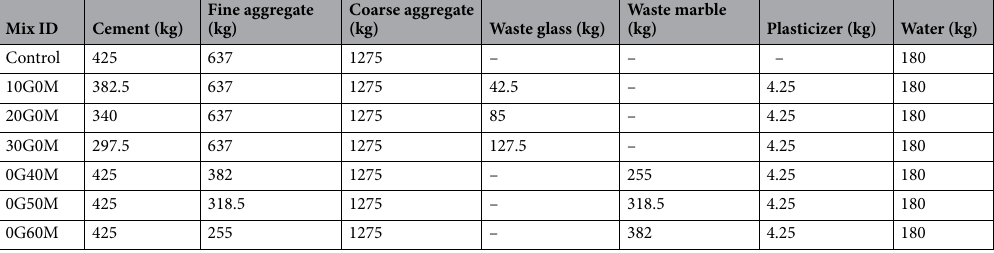
Table 4. Mix proportion of materials per m 3